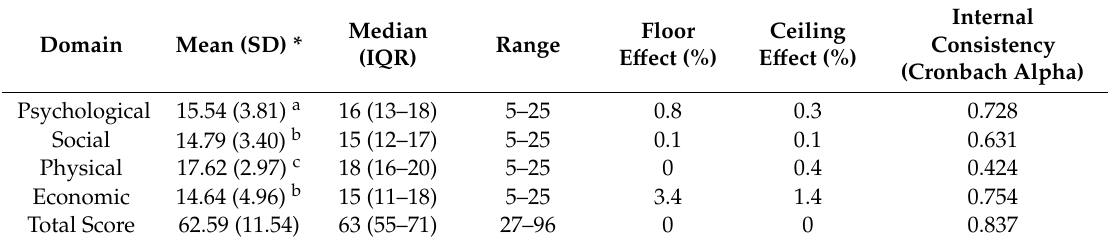
Table 2. The precision of the questionnaire and its domains ( n =